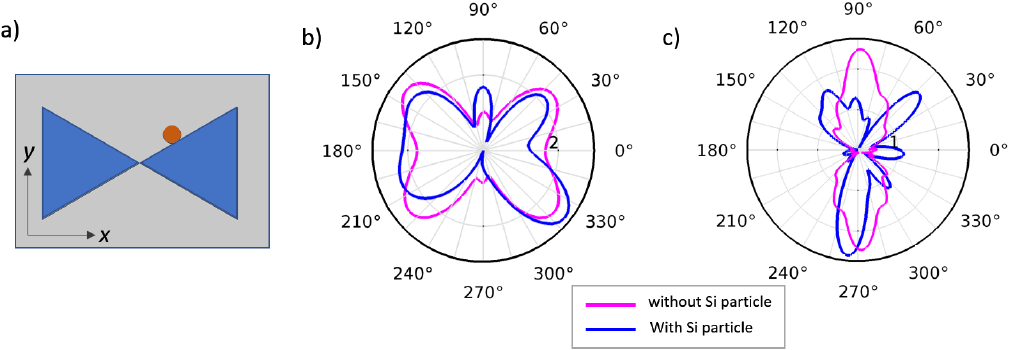
Figure A3. ( a ) The schematic sketch of the proposed bow-tie antenna with a silicon particle on top (orange sphere). The fundamental ( b ) and second harmonic ( c ) far field modification in the presence of the silicon particle.